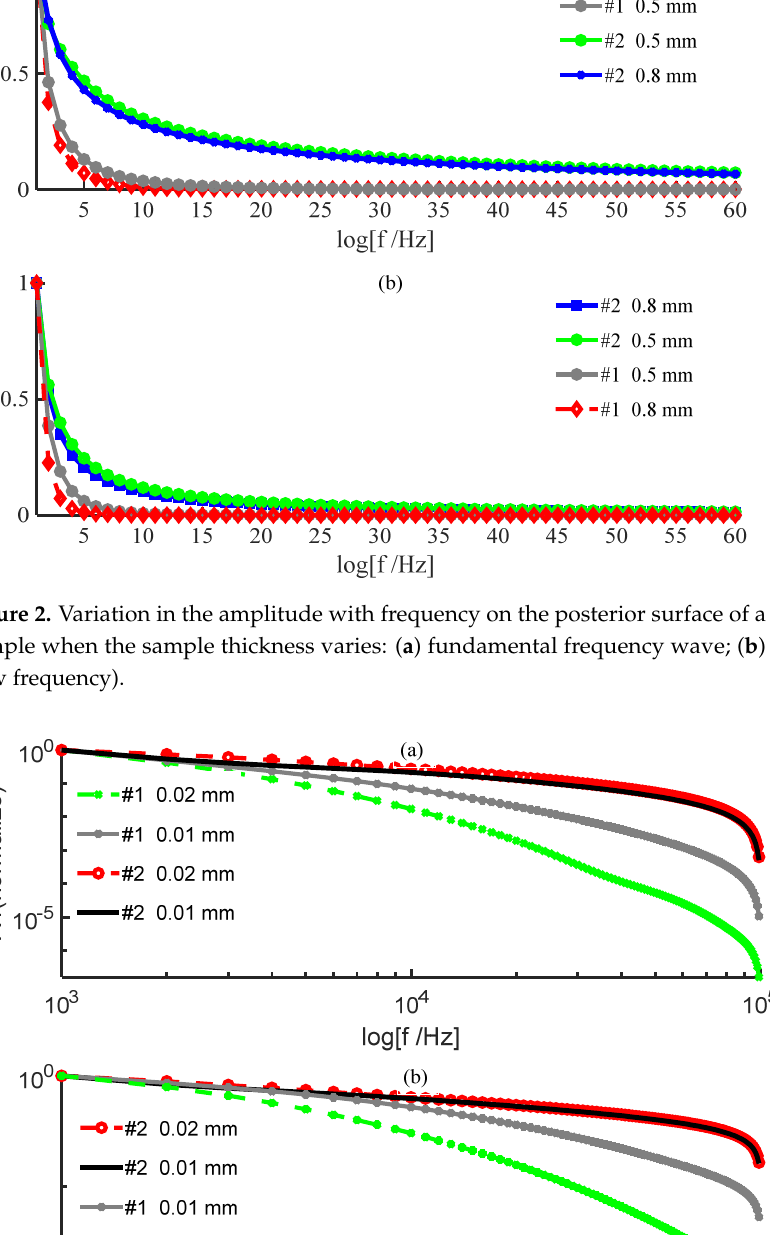
surface of the PWS samples obtained by both numerical methods decreases with increasing frequency when other parameters are constant and the thickness of the samples is d = 0.01 mm and d = 0.02 mm.